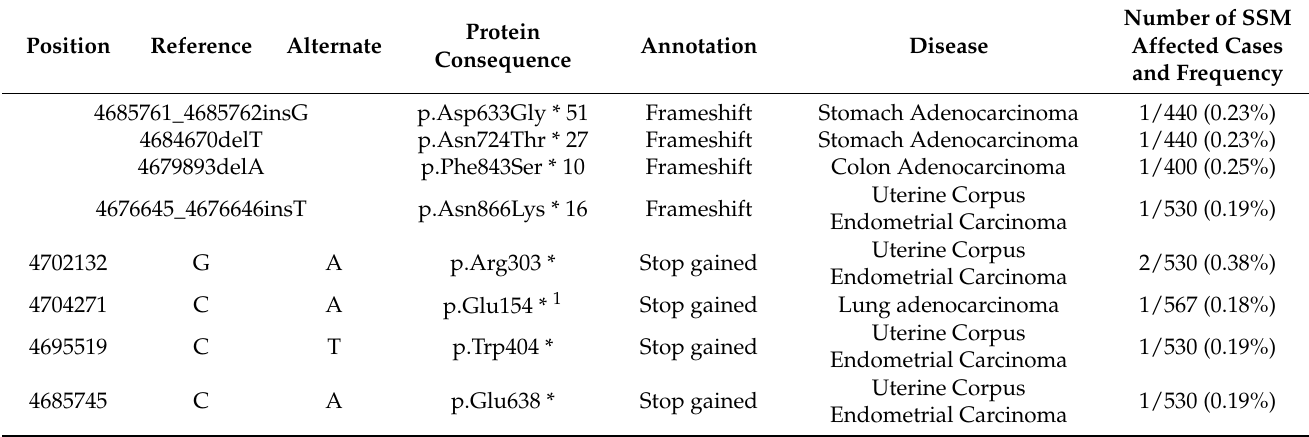
Table 4. DPP9 LoF variants in TCGA. Simple somatic mutation (SSM) affected frequency was calculated as the number of cases affected by a specific mutation in a TCGA disease project divided by the number of cases tested for SSM in that disease project in TCGA. ins = insertion. del = deletion. * Premature termination codon